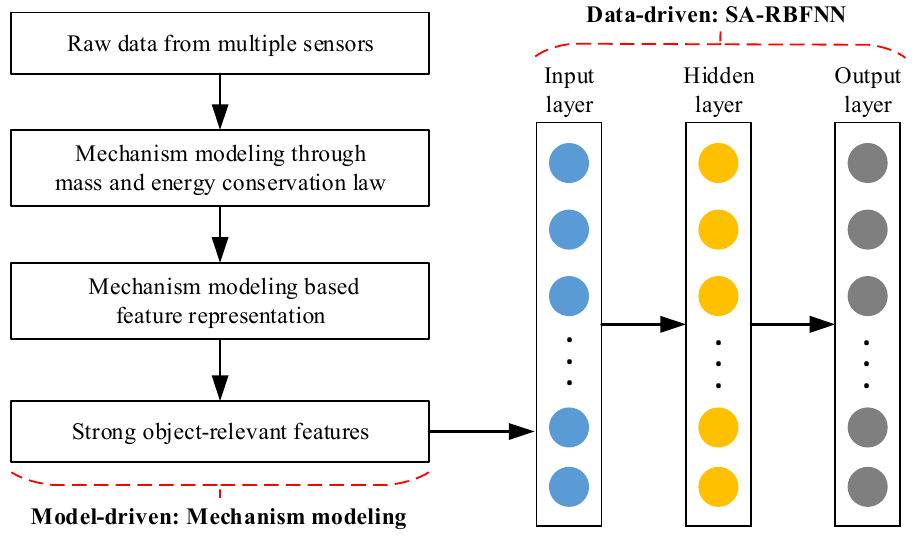
Figure 3. Architecture of the proposed hybrid soft sensor method.